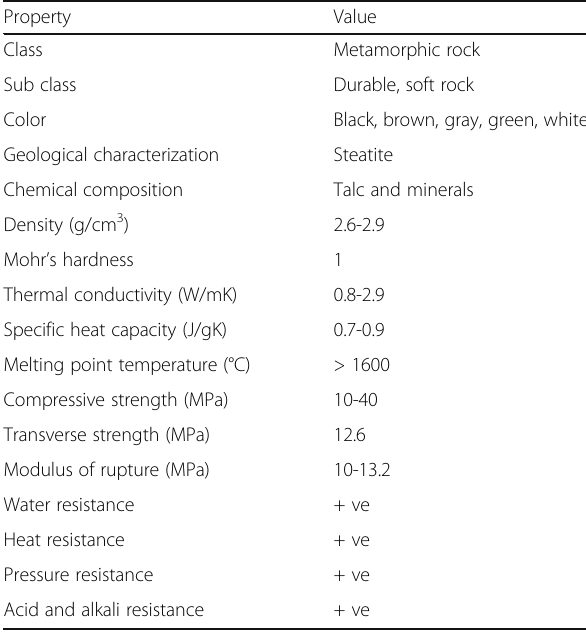
Table 1 The physical, chemical, mechanical, and thermal properties of soapstone (Gökçe et al. 2011; Hand 2020; Reynard et al. 2008; Santi et al.